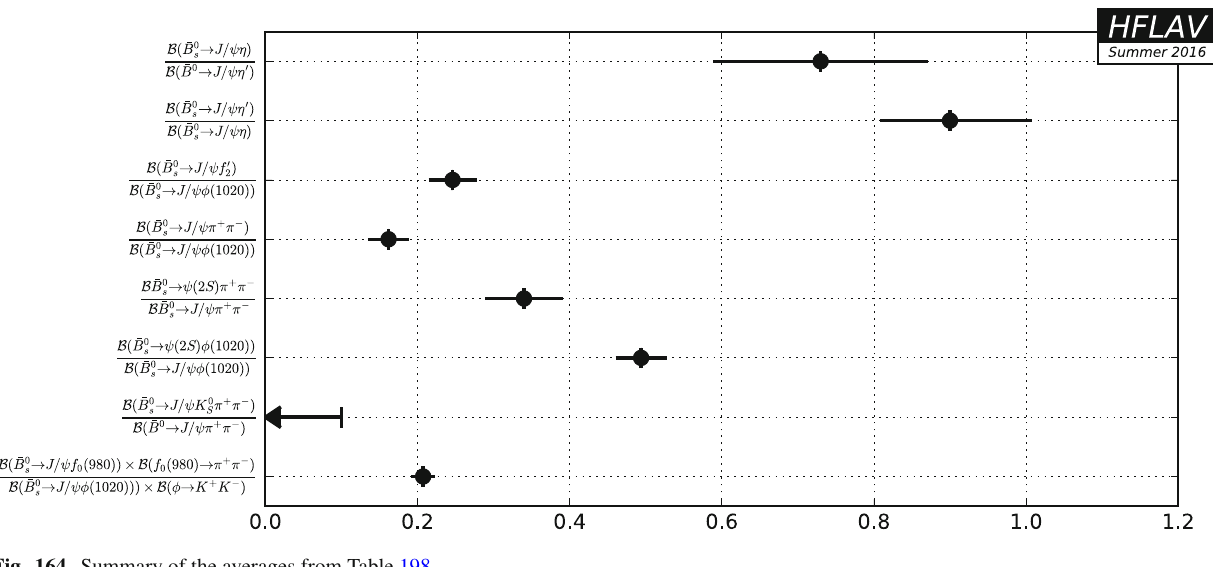
Fig. 164 Summary of the averages from Table 198